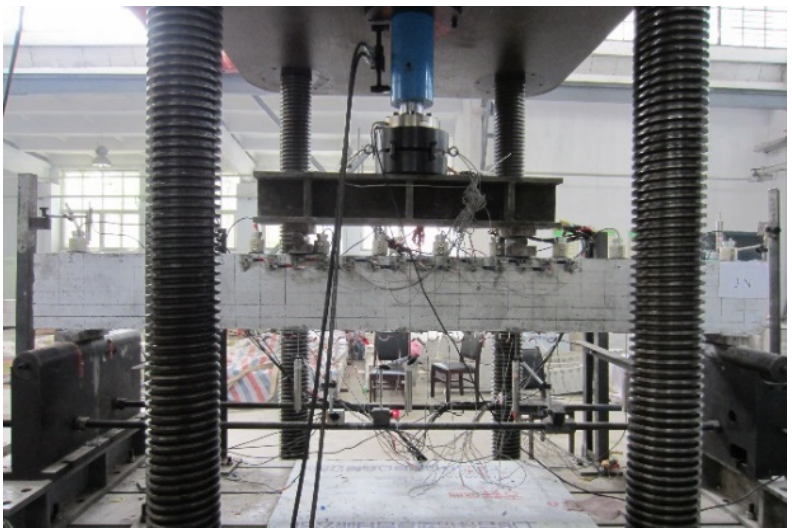
Figure 3. The test apparatus and loading set-up.